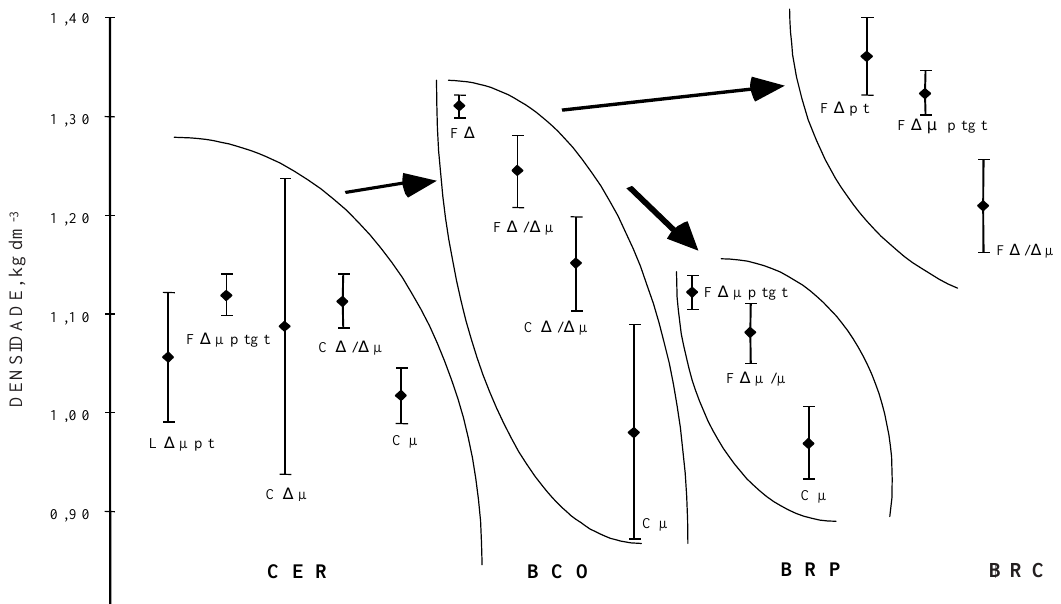
Figura 2. Densidade do solo nos torrões (kg dm -3 ) dos diferentes volumes estruturais amostrados nos perfis.